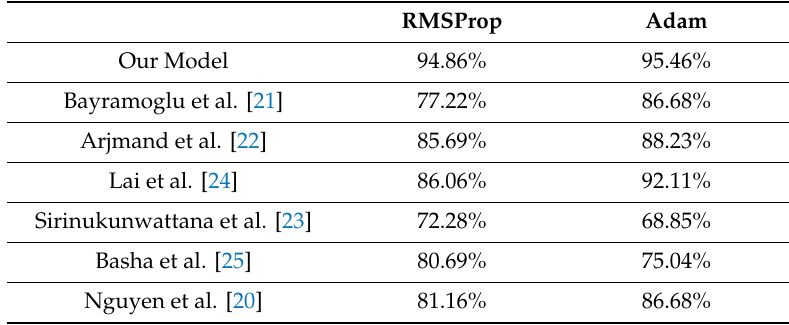
Table 8. The AUC results of the State-of-the-art